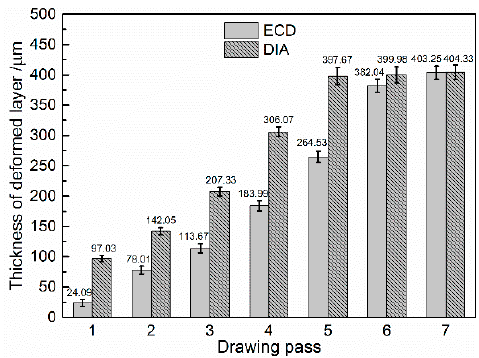
Figure 5. Surface deformation layer thickness of ECD and DIA bars processed for different drawing passes.